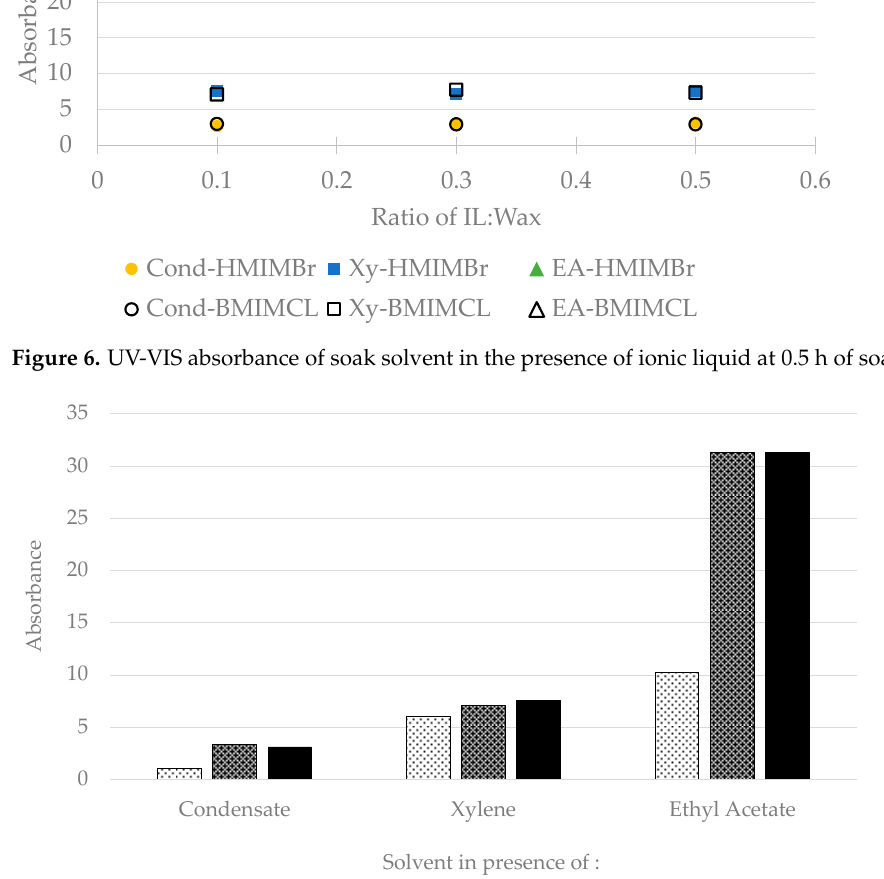
Figure 6. UV-VIS absorbance of soak solvent in the presence of ionic liquid at 0.5 h of soaking time.